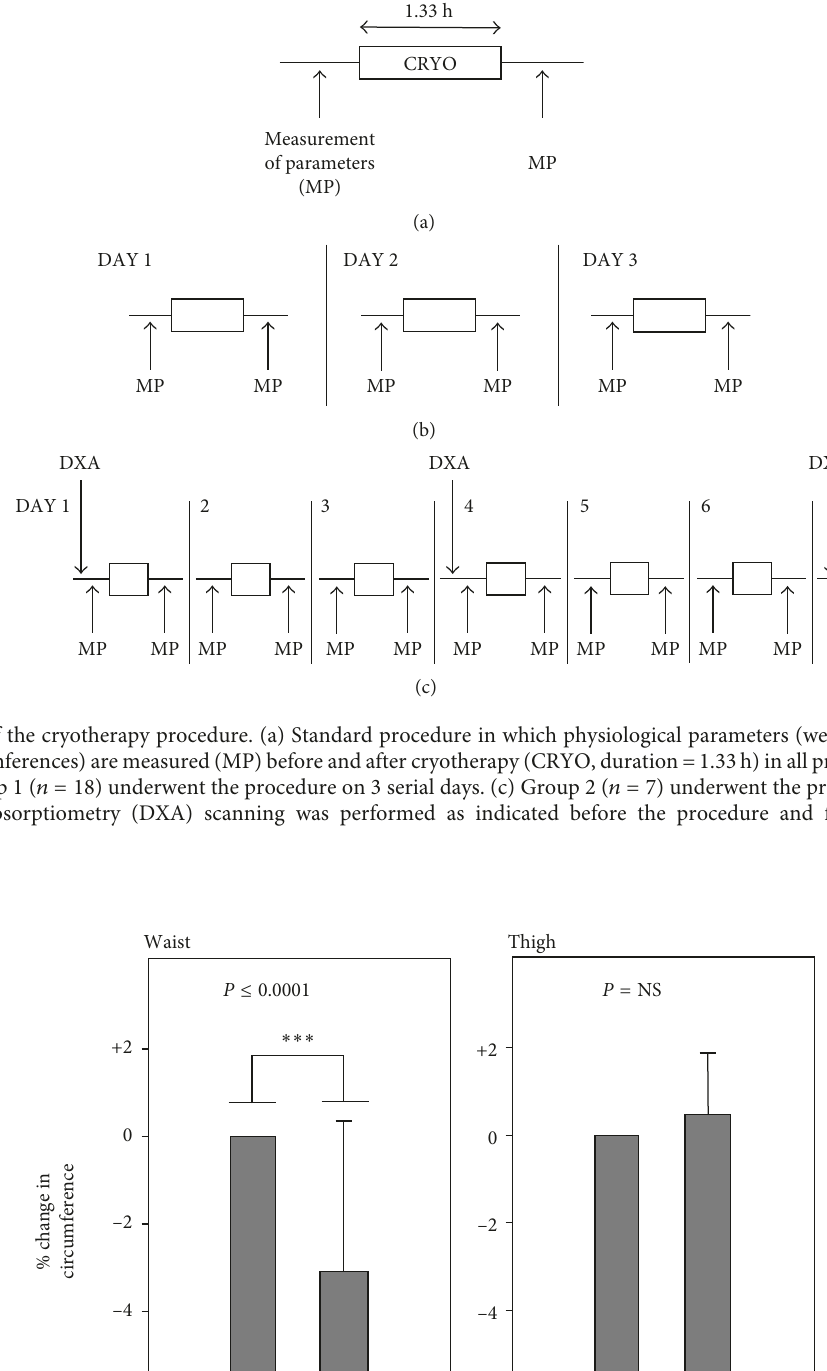
Figure 2: Percentage change in (a) waist circumference and (b) thigh circumference, following single abdominal applications of tissue cryotherapy (group 1; duration of the procedure, ca. 1.33h; time following the procedure, ca. 1h). Error bars indicate SD; error bars are not shown for the left-hand plots in each panel because these were normalized to